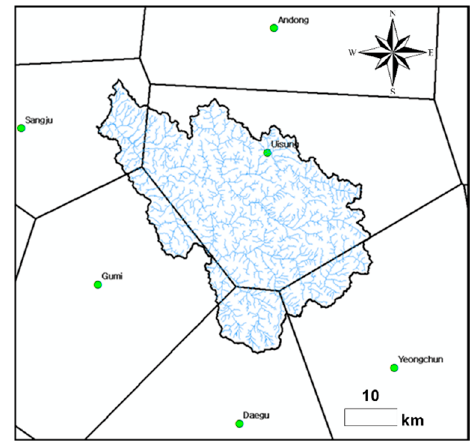
Table 1. Theissen weight for each rainfall station in Wicheon watershed.